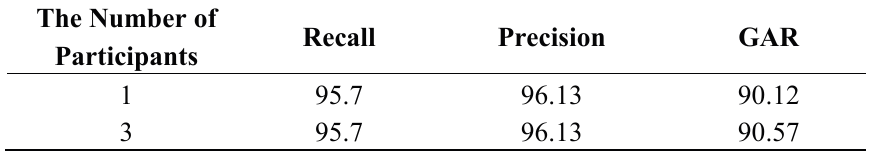
Table 4. Experimental Results based on the Number of Participants (unit: